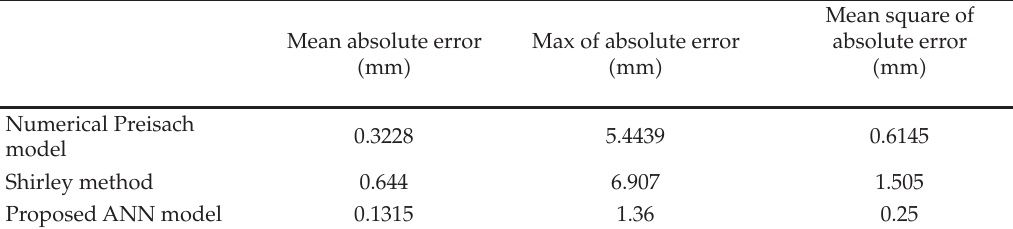
Table 3: Error of the three considered models in the first validation process.